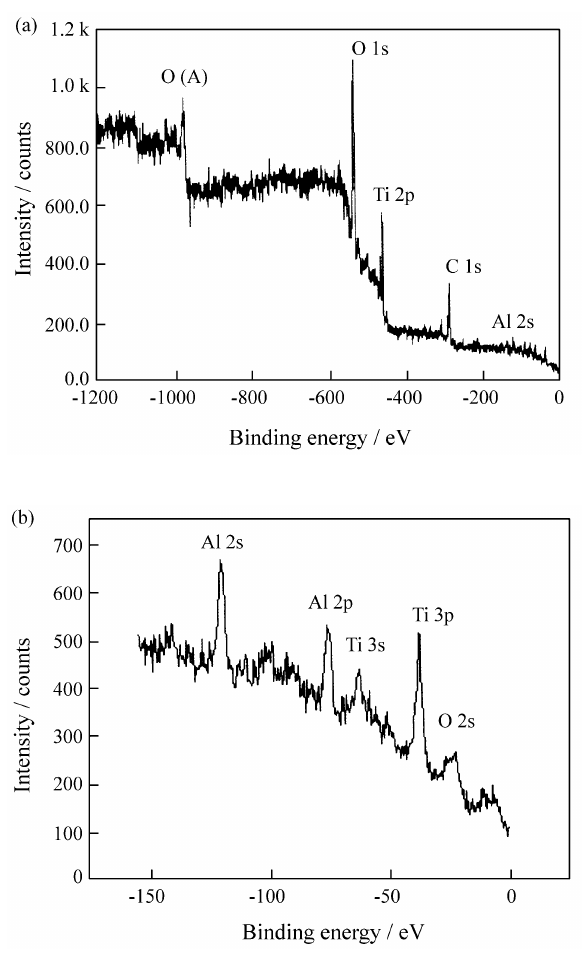
Figure6. XPSspectraforAl 2 O 3 -blastedsample.a)generalview;b)detail near aluminium peak.